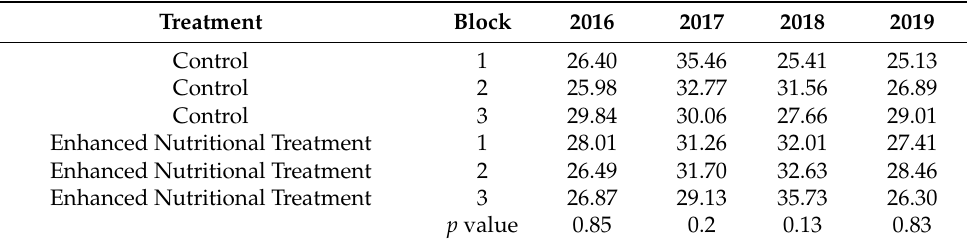
Figure 1. Changes in yields and canopy density and volume after CRF treatment. After three years of CRF treatment, trees had higher yields ( A ). Loss of canopy density (measured as leaf area index) was smaller in CRF treated trees than in controls ( B ). There was no difference in canopy volume ( C ). Table 1. CLas Ct values at the beginning of CRF treatments (2016) and during the three years of CRF experiment.